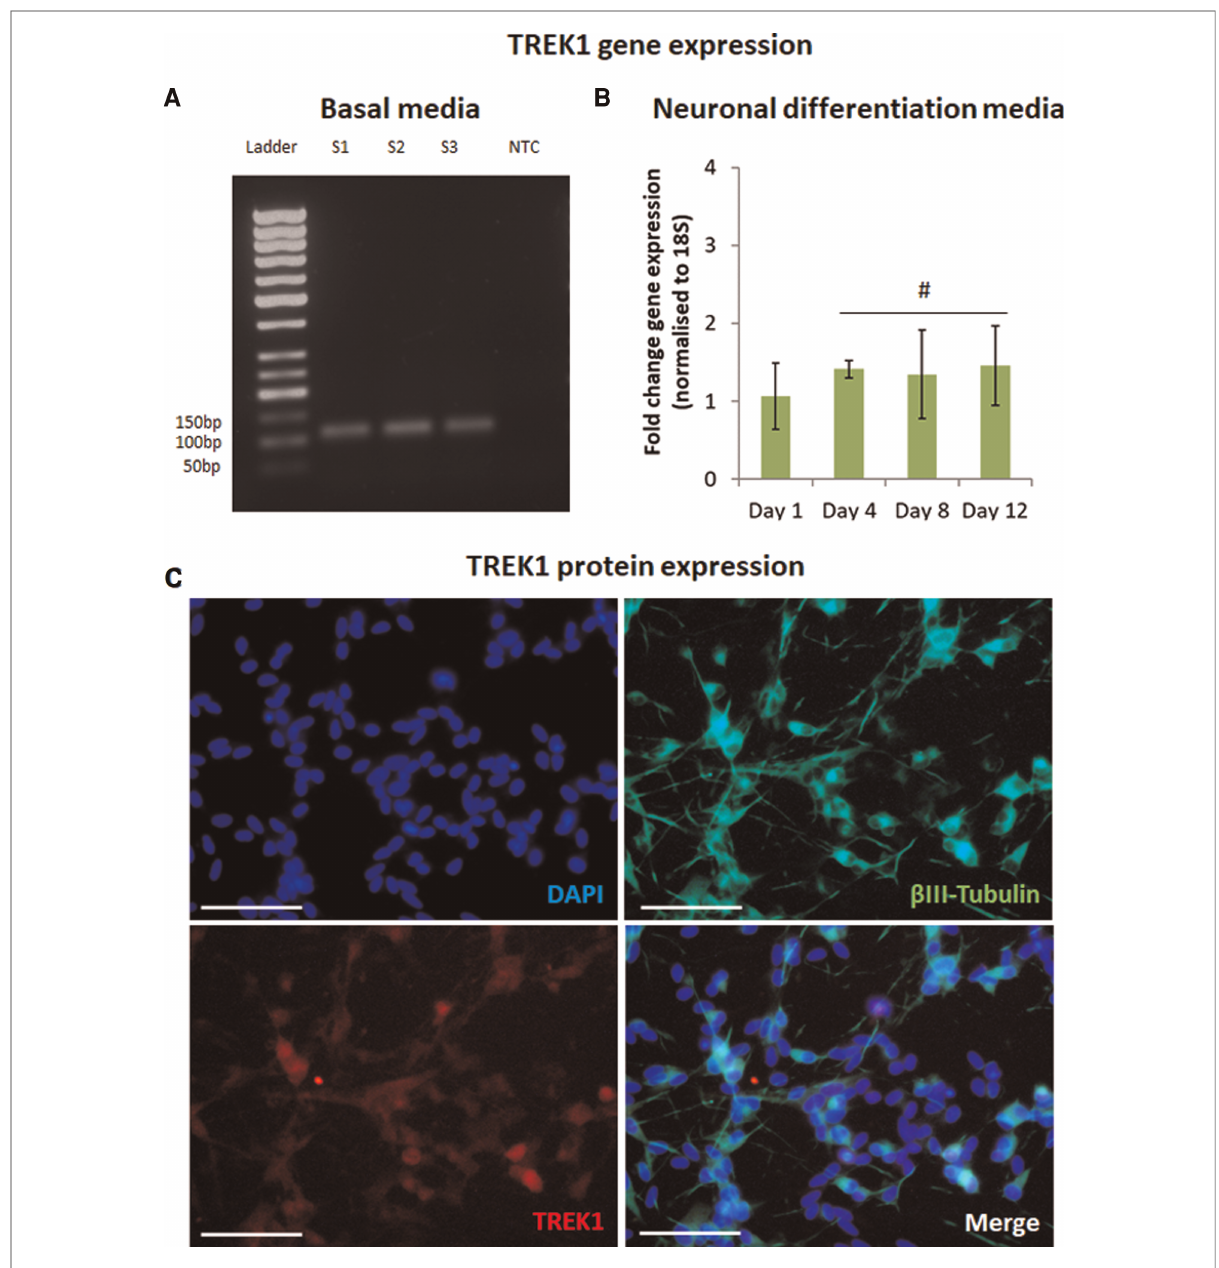
FIGURE 1 TREK1 is expressed by SH-SY5Y. Reverse transcription-PCR con fi rmed TREK1 gene expression in SH-SY5Y in basal media, S1-3 represent sample number ( n =3), NTC represents non-template control ( A ). Quantitative reverse transcription-PCR indicated TREK1 gene expression remained broadly stable with minor increases in expression over 12 days in neuronal differentiation media ( B ), n =3, # represents ANOVA p >0.05, bars represent mean fold change, error bars represent standard deviation. Immuno fl uorescent microscopy con fi rmed that differentiated neurons expressing β III-Tubulin (Green) also expressed TREK1 (Red) ( C ), Cell nuclei is shown by DAPI staining (Blue), images representative of n =3, scale bar represents 50 μ